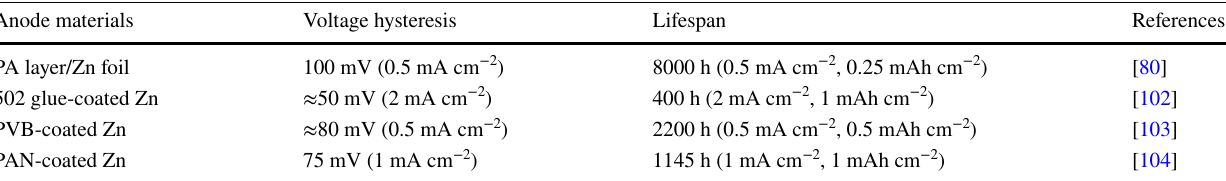
Table 3 Summary of recently reported coatings modification strategies for polymer Anode materials Voltage